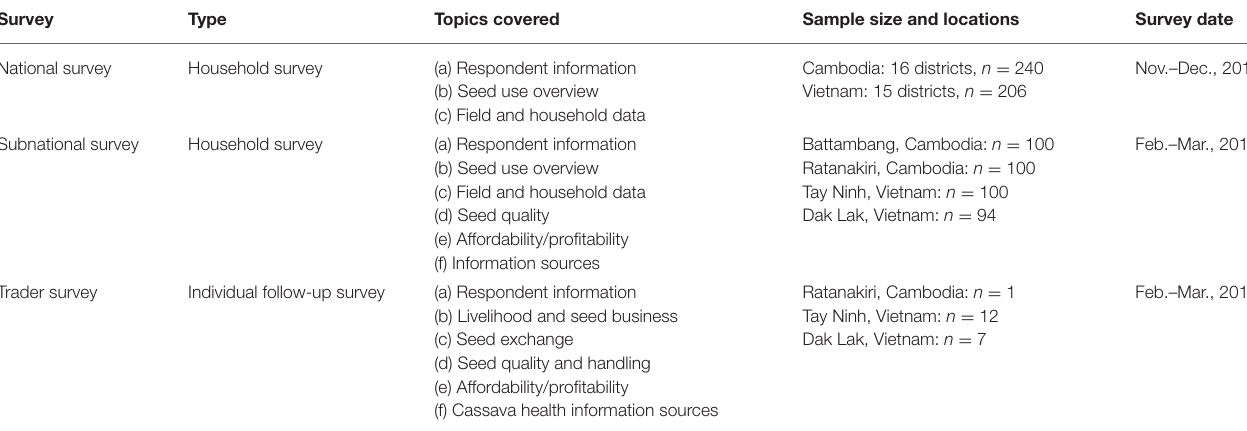
TABLE 1 | Characteristics of project surveys implemented in Vietnam and Cambodia,